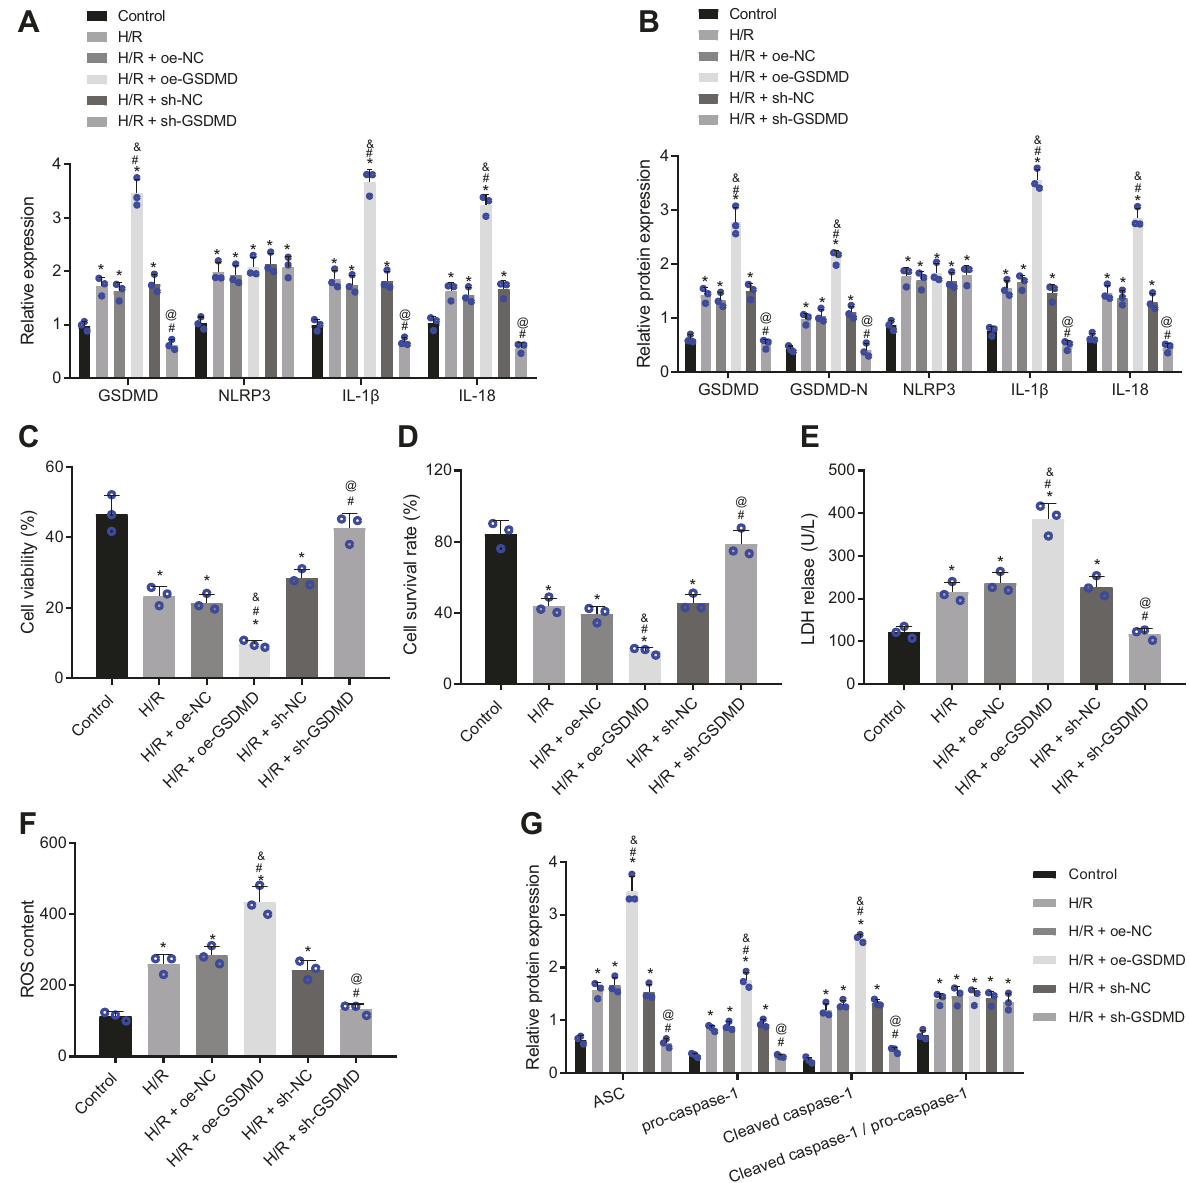
Fig. 3 GSDMD induces H/R-induced myocardial cell pyroptosis and injury. A The relative mRNA expression of GSDMD, NLRP3, IL-1 β , and IL- 18 in H/R-exposed myocardial cells detected by RT-qPCR; B Western blot analysis of GSDMD, NLRP3, IL-1 β , IL-18, and GSDMD N proteins in H/ R-exposed myocardial cells, normalized to GAPDH; C The viability of H/R-exposed myocardial cells assessed by Calcein-AM/PI double staining. D The H/R-exposed myocardial cell survival rate measured by trypan blue staining; E LDH release in H/R-exposed myocardial cells detected by LDH kit; F ROS production in H/R-exposed myocardial cells stained with DCFH-DA; G Western blot analysis of ASC, pro-caspase-1, and caspase- 1 proteins as well as a cleaved caspase-1/pro-caspase-1 ratio in H/R-exposed myocardial cells, normalized to GAPDH. Measurement data were expressed as mean ± standard deviation. The comparison among multiple groups was conducted with one-way ANOVA, followed by Tukey ’ s post hoc test. Each cell experiment was repeated three times independently. * P < 0.05 vs. untreated myocardial cells, # P < 0.05 vs. H/R-exposed myocardial cells, & P < 0.05 vs. H/R-exposed myocardial cells transfected with oe-NC, @ P < 0.05 vs. H/R myocardial cells transfected with